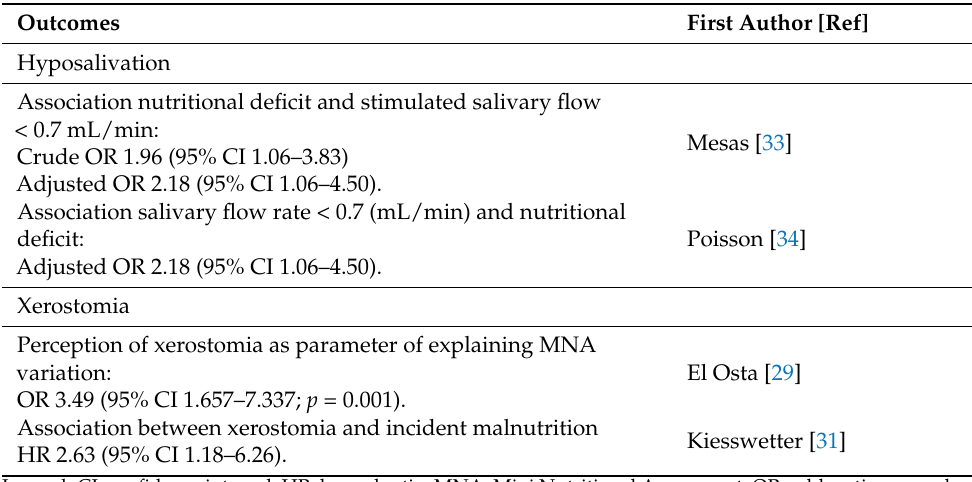
Table 4. Outcome measures regarding hyposalivation and xerostomia in malnourished older people compared to well-nourished older